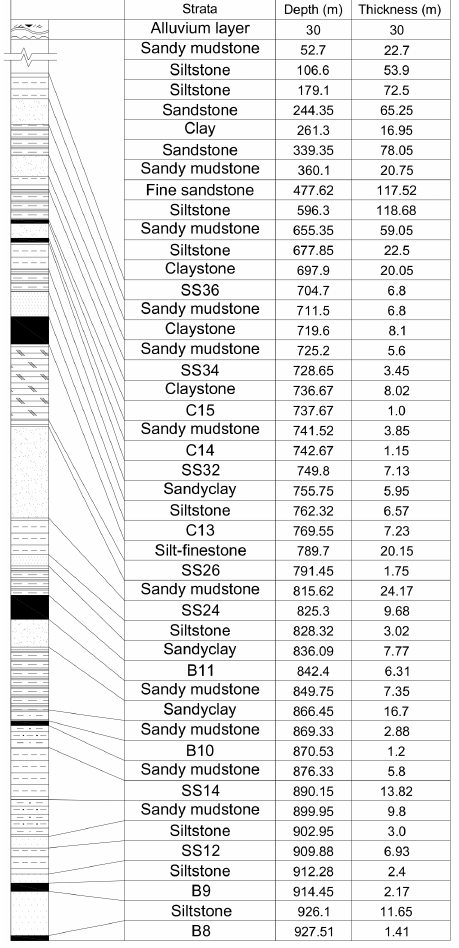
Figure 1. A simplified stratigraphic section of the studied mine. B8, B9, B10, B11, C13, C14 and C15 are coal seams; SS12, SS14, SS24, SS26, SS32, SS34 and SS36 are sandstone units used to correlate stratigraphy between different